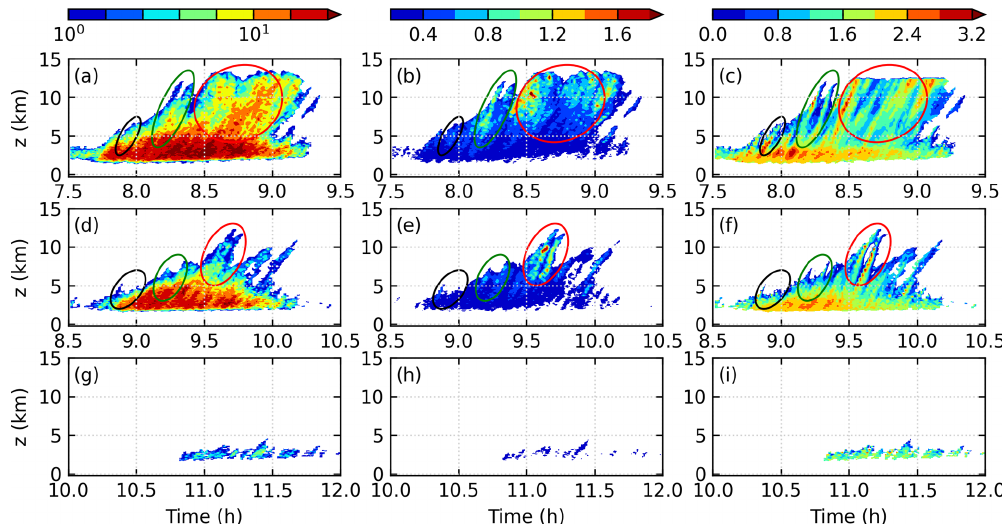
Figure 17. (a) Number, (b) mean size (km), and (c) mean temperature surplus (K) of the convective cells in simulation THF700. Note that a logarithmic scale is used in panel (a) . Panels (d–f) and (g–i) are the same as (a–c) except for simulations THF500 and THF300. The black, green, and red ellipses indicate the first, second, and third generations of convection, respectively.